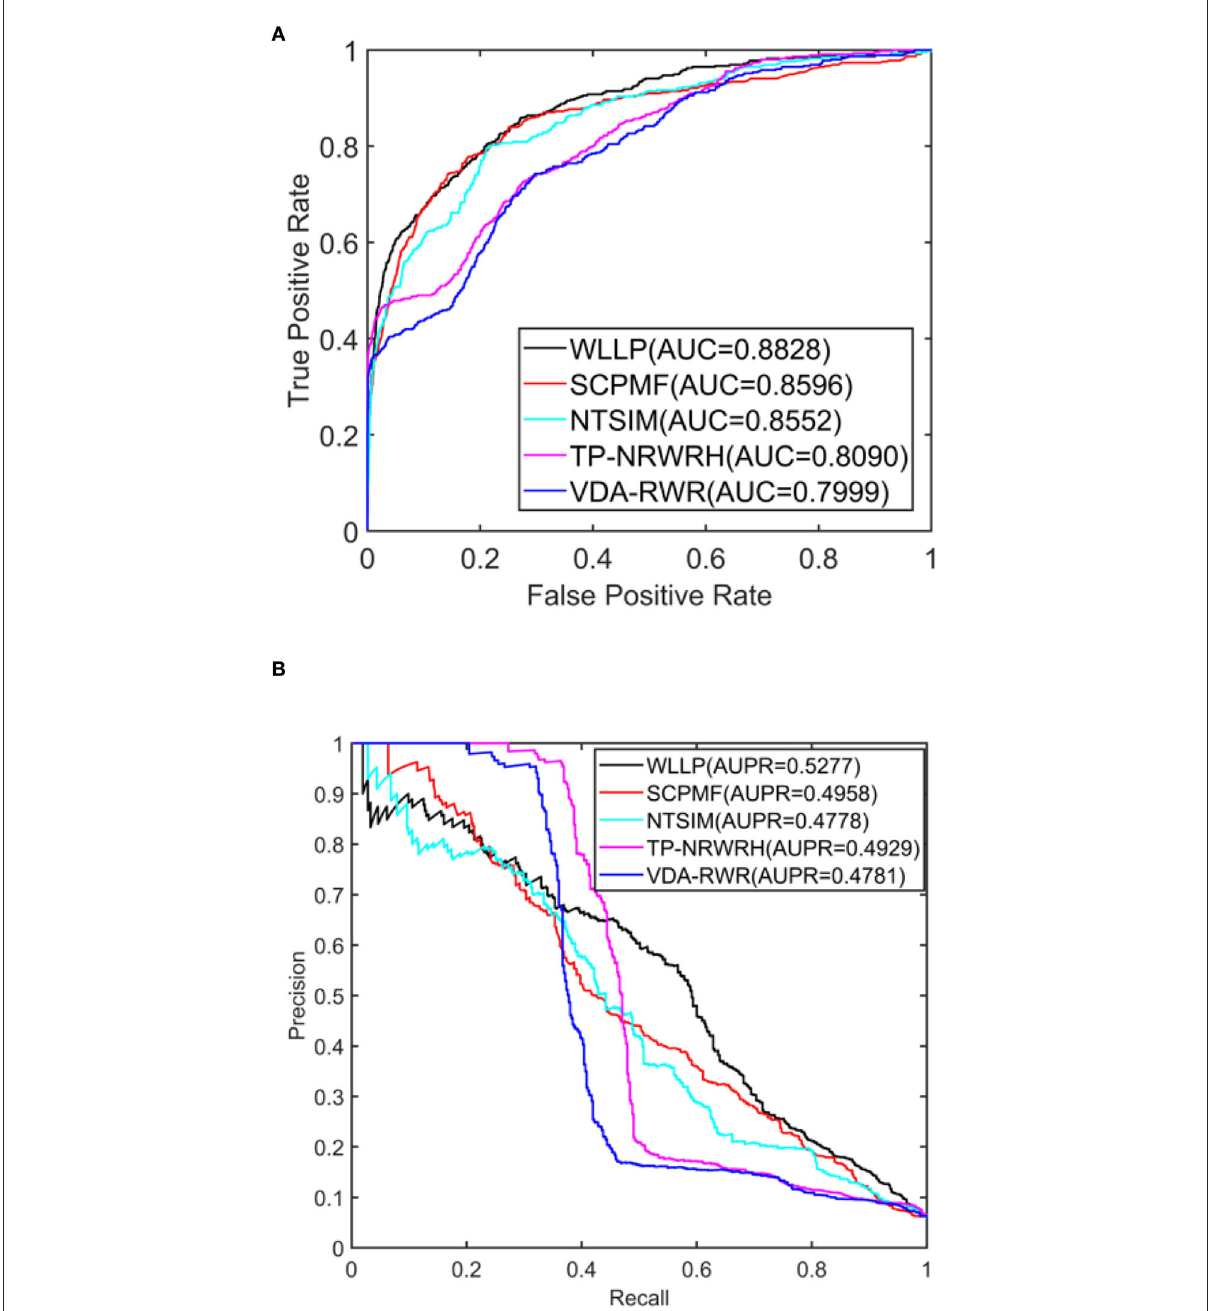
FIGURE2 Area under the receiver operating characteristic curve (AUC) and area under the precision-recall curve (AUPR) values of the five prediction methods on the human drug virus database (HDVD) dataset. (A) AUC values of the five prediction methods. (B) AUPR values of the five prediction